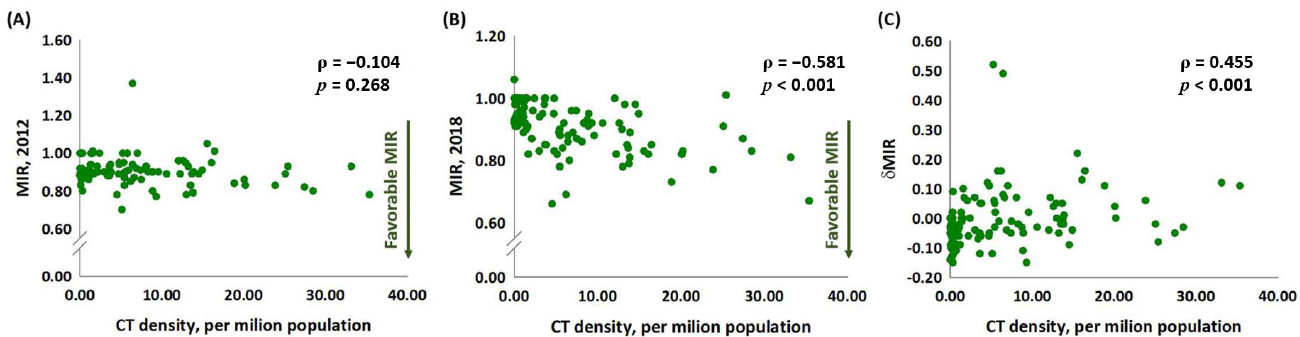
Figure 2. Lack of an association between the CT density and the MIR in 2012 ( A ). However, CT density was significantly associated with ( B ) MIR in 2018 and ( C ) δ MIR in lung